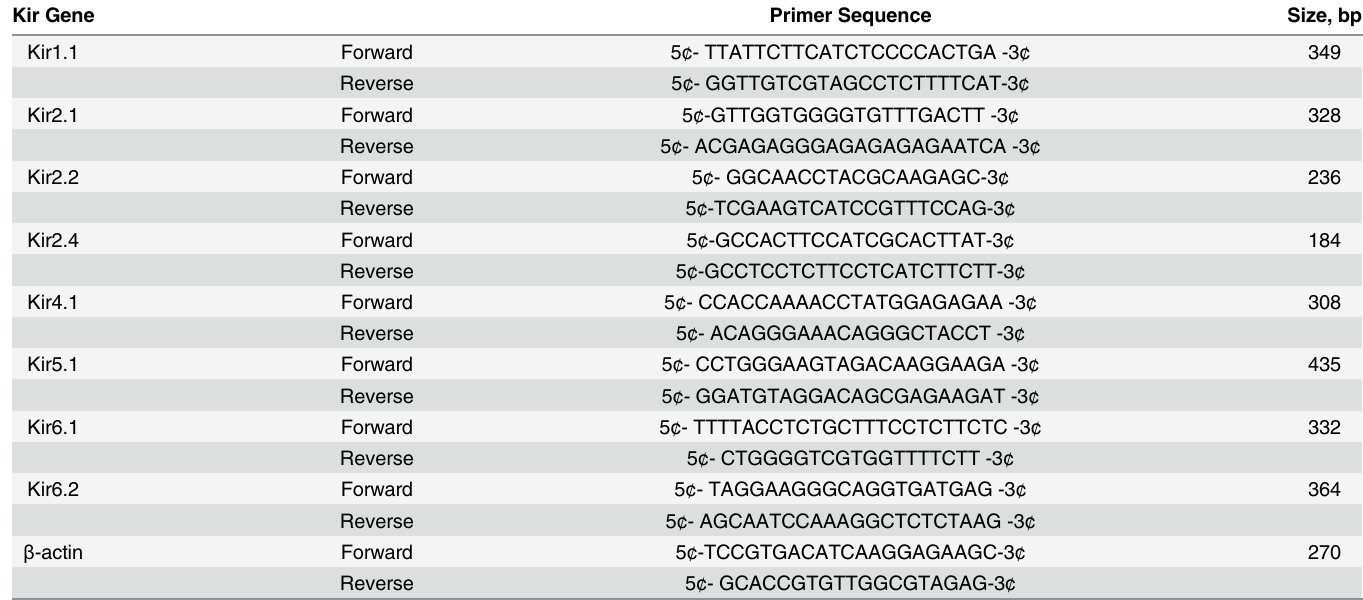
Table 1. Gene-specific primers designed and expected length of RT-PCR products. Kir